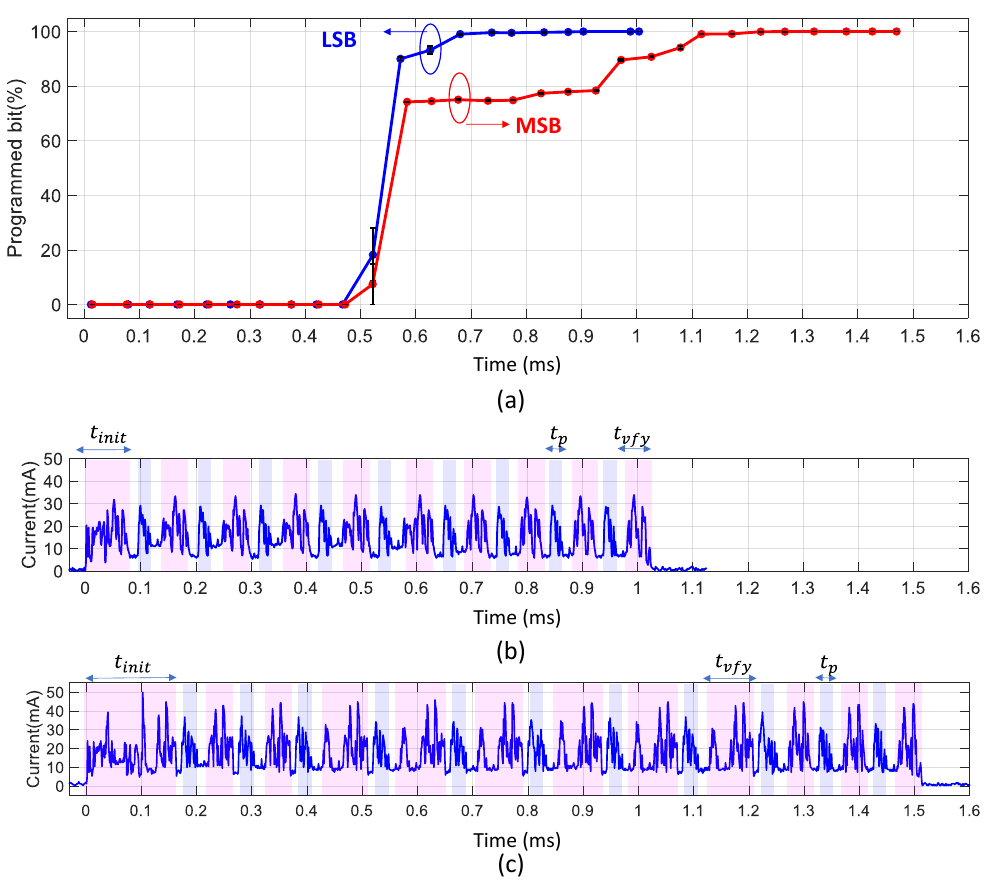
Figure 8. ( a ) percentage of programmed bits for a page in MLC mode as a function of the partial-page program time, t pp . Measured current drawn during regular-page program operations in MLC mode for the ( b ) LSB page and ( c ) MSB page.